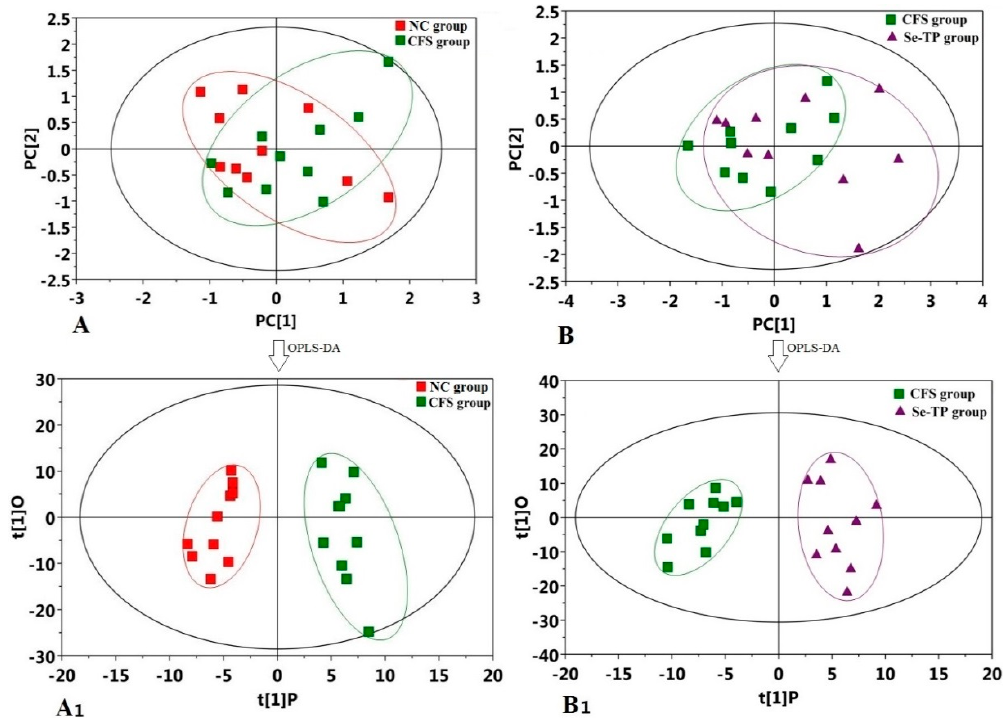
Figure 6. Results of multivariate statistical analysis: ( A ) PCA scores plot (CFS group vs. NC group), ( B ) PCA scores plot (Se-TP group vs. CFS group), ( A 1 ) OPLS-DA scores plot (CFS group vs. NC group), ( B 1 ) OPLS-DA scores plot (Se-TP group vs. CFS group).